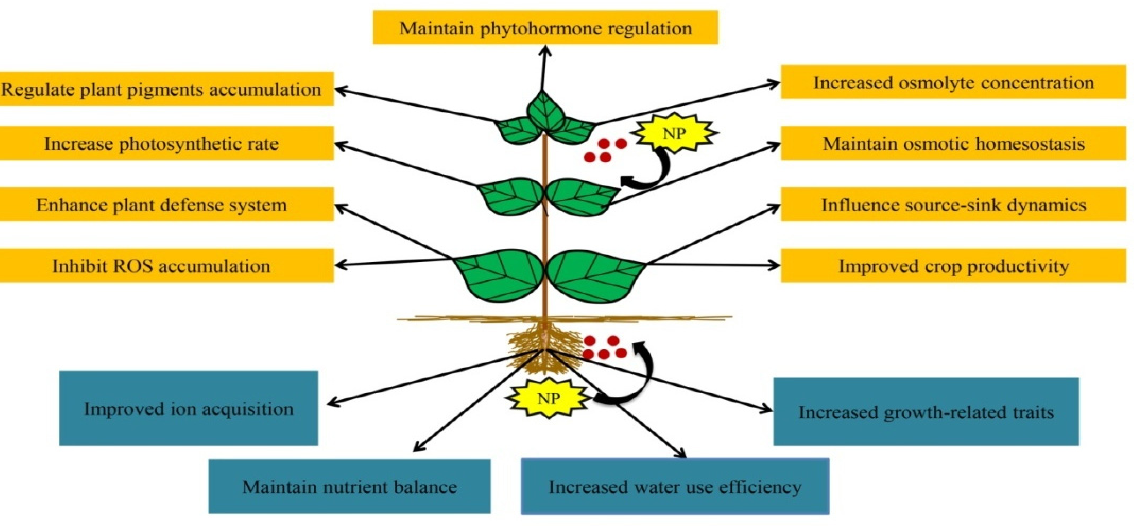
Figure 1. A summary of physiological and biochemical responses in plants on exogenous application of green synthesized nanoparticles by foliar application or direct administration in the soil.